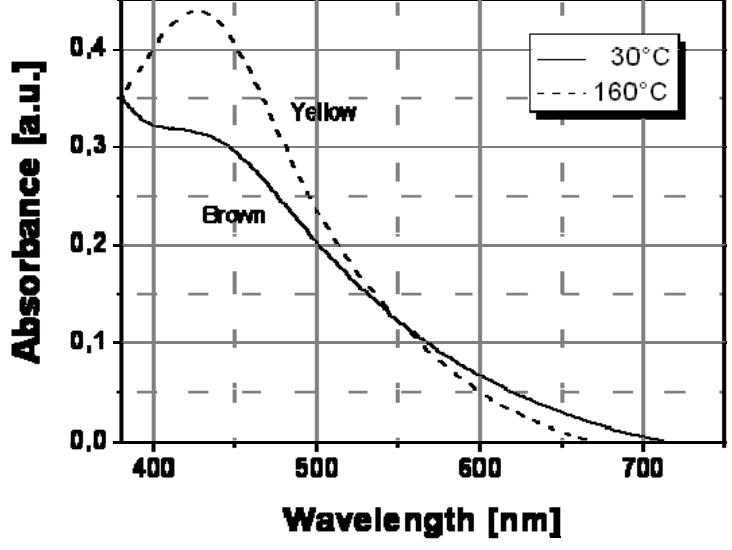
Figure 7. Absorption spectra recorded at two different temperatures for Ag/PS nanocomposite film obtained by thermal decomposition of silver dodecyl-thiolate in amorphous